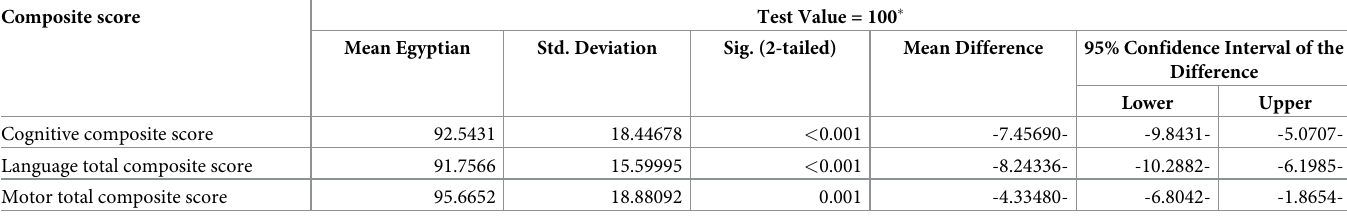
Table 1. The difference between mean Egyptian and mean American composite scores in each subtest of Bayley Scales.